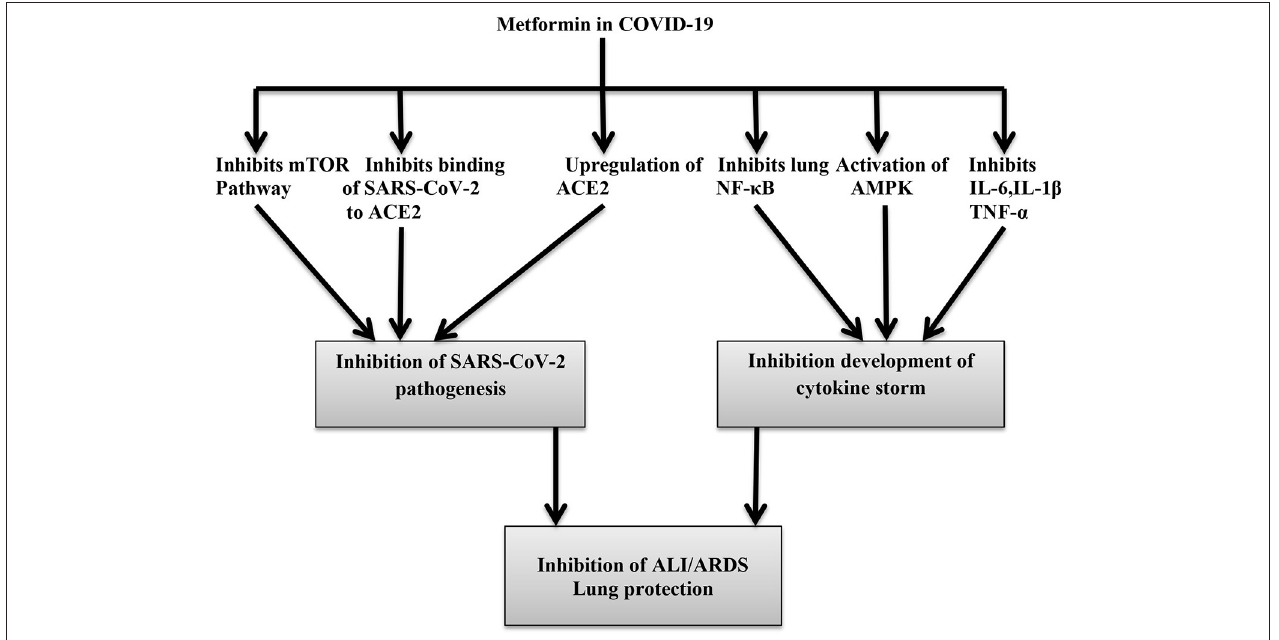
FIGURE 5 | Metformin inhibits pathogenesis of COVID-19 through inhibition of pro-inflammatory cytokines, inflammatory signaling pathway, and binding to